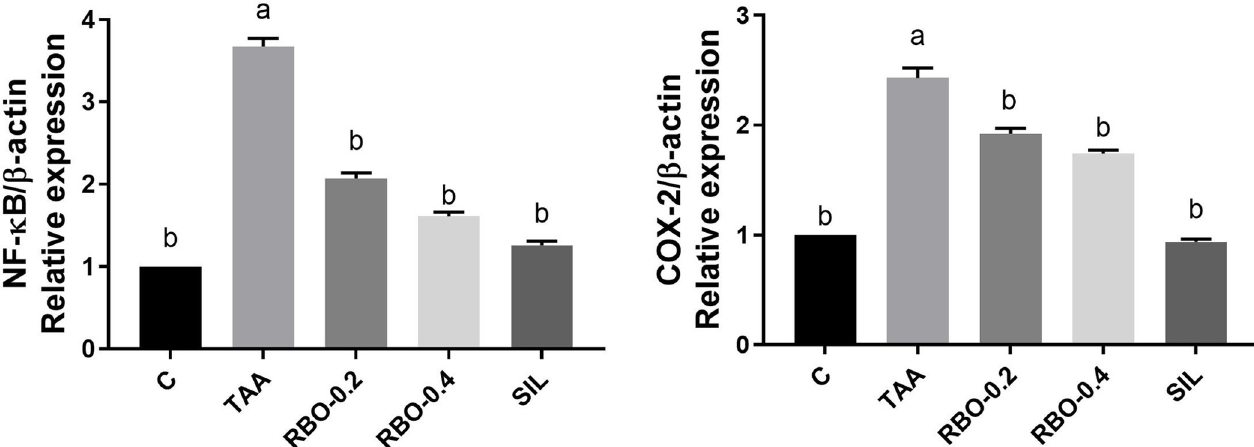
Fig 9. Effect of RBO on NF- κβ and COX-2 in TAA-induced liver fibrosis in rats. Control rats, treated with saline; TAA rats, treated with thioacetamide (100 mg/kg; three times per week for 2 weeks, ip ); RBO rats, treated with TAA, RBO (0.2 and 0.4 mL/rat; daily for 2 weeks, po ) and silymarin (100 mg/kg, po ). All data are presented as Mean ± SEM, (n = 6). a P � 0.05 was assumed to denote statistical significance compared to the negative control, b P � 0.05 was assumed to denote statistical significance compared to TAA group. TAA, Thioacetamide; RBO, Rice bran oil; NF- κβ , Nuclear factor kappa B; COX-2,